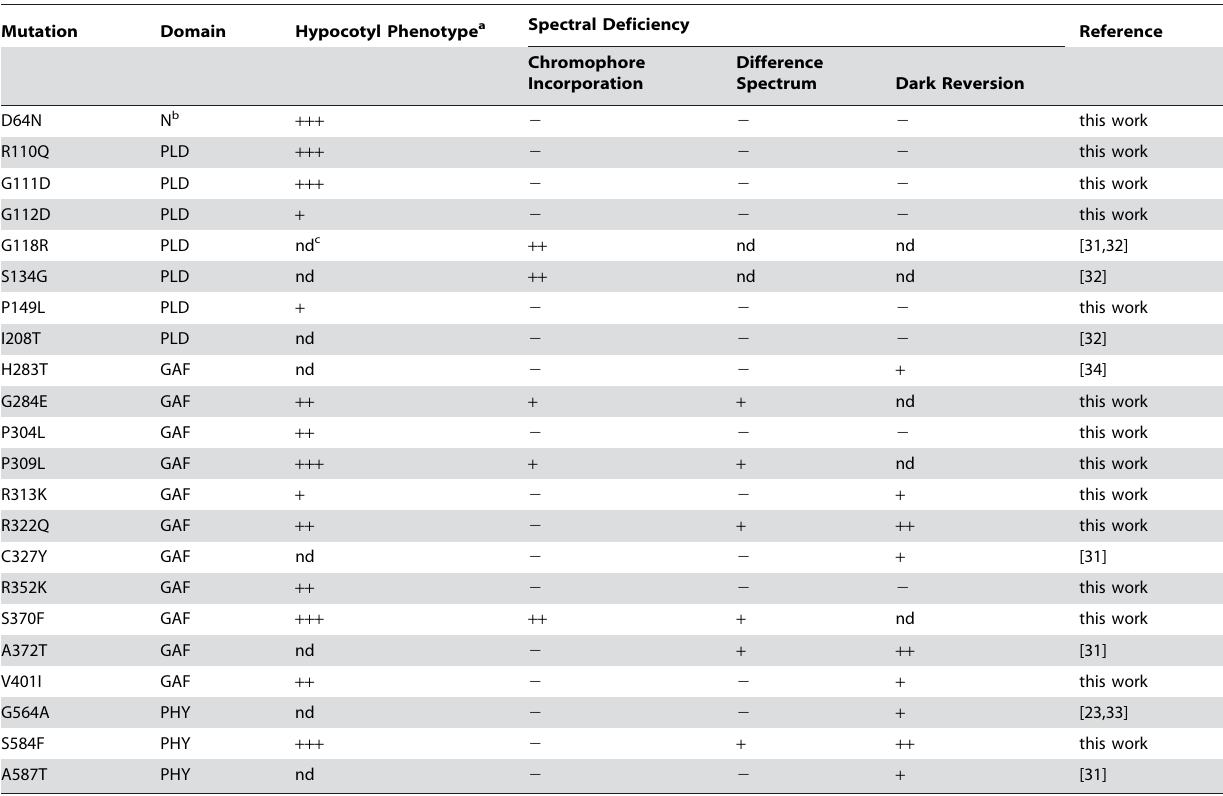
Table 1. Summary of the phyB